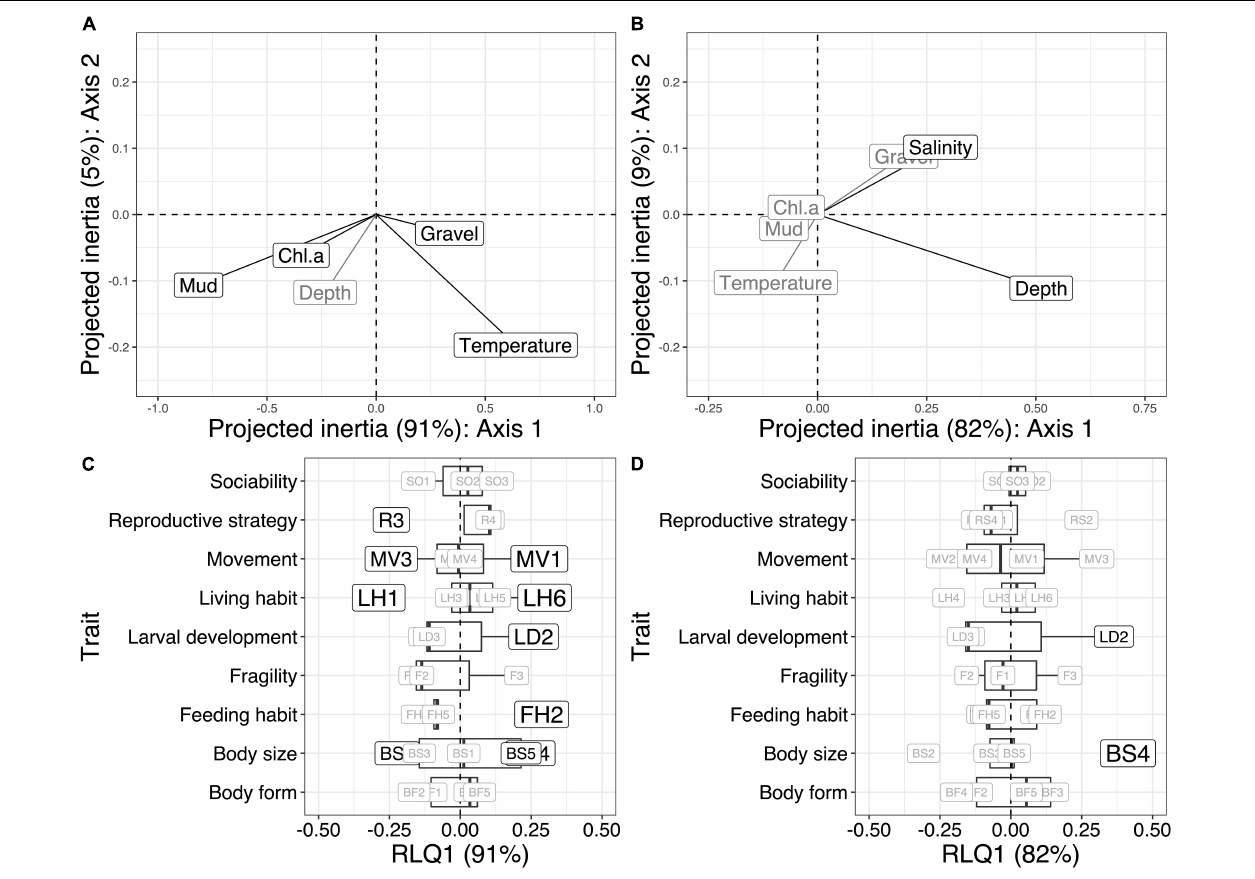
FIGURE 4 | The covariation of the first two RLQ axes of the environmental variables are shown for the Chukchi Sea (A) and Beaufort Sea (B) . Significant relationships of environmental variables to RLQ trait axes ( p < 0.05) are shown in black while environmental variables with non-significant relationships to RLQ trait axes are shown in gray for the Chukchi Sea (A) and Beaufort Sea (B) . Significant relationships of modalities ( p < 0.05) to the first RLQ environmental axes are shown for the Chukchi and Beaufort Sea (C,D) . Size of the modality boxes correspond to the strength of the Pearson correlation values. Modality abbreviations are shown in Table 1 and RLQ outputs are shown in Table 2